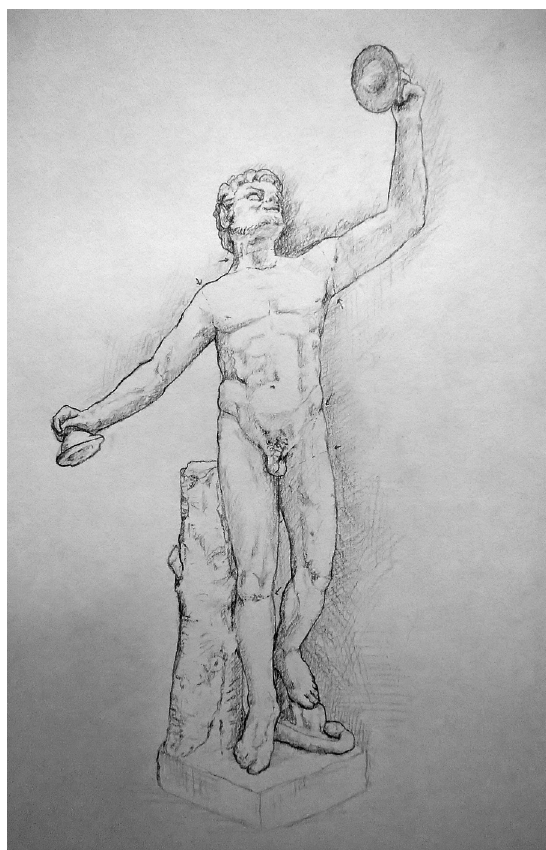
Figure 1: An example of a “ restored ” or completed archaeological object, a dancing Roman faun from the second century. Only the torso and the right thigh are antique ( arrows indicating the breaks ) . The “ Rondanini Faun ” was completed by François Duquesnoy somewhere between 1630 and 1635 ( British Museum, museum no. 1988,1208.1; drawing by the author when it was on display in the exhibition “ Caravaggio - Bernini. Baroque in Rome, ” Rijksmuseum in Amsterdam, 14 February to